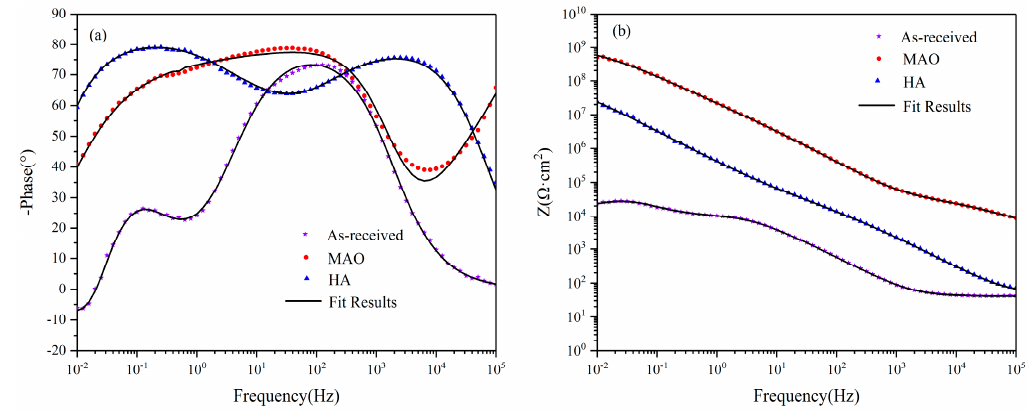
Table 2. Fitting results of potentiodynamic polarization tests.